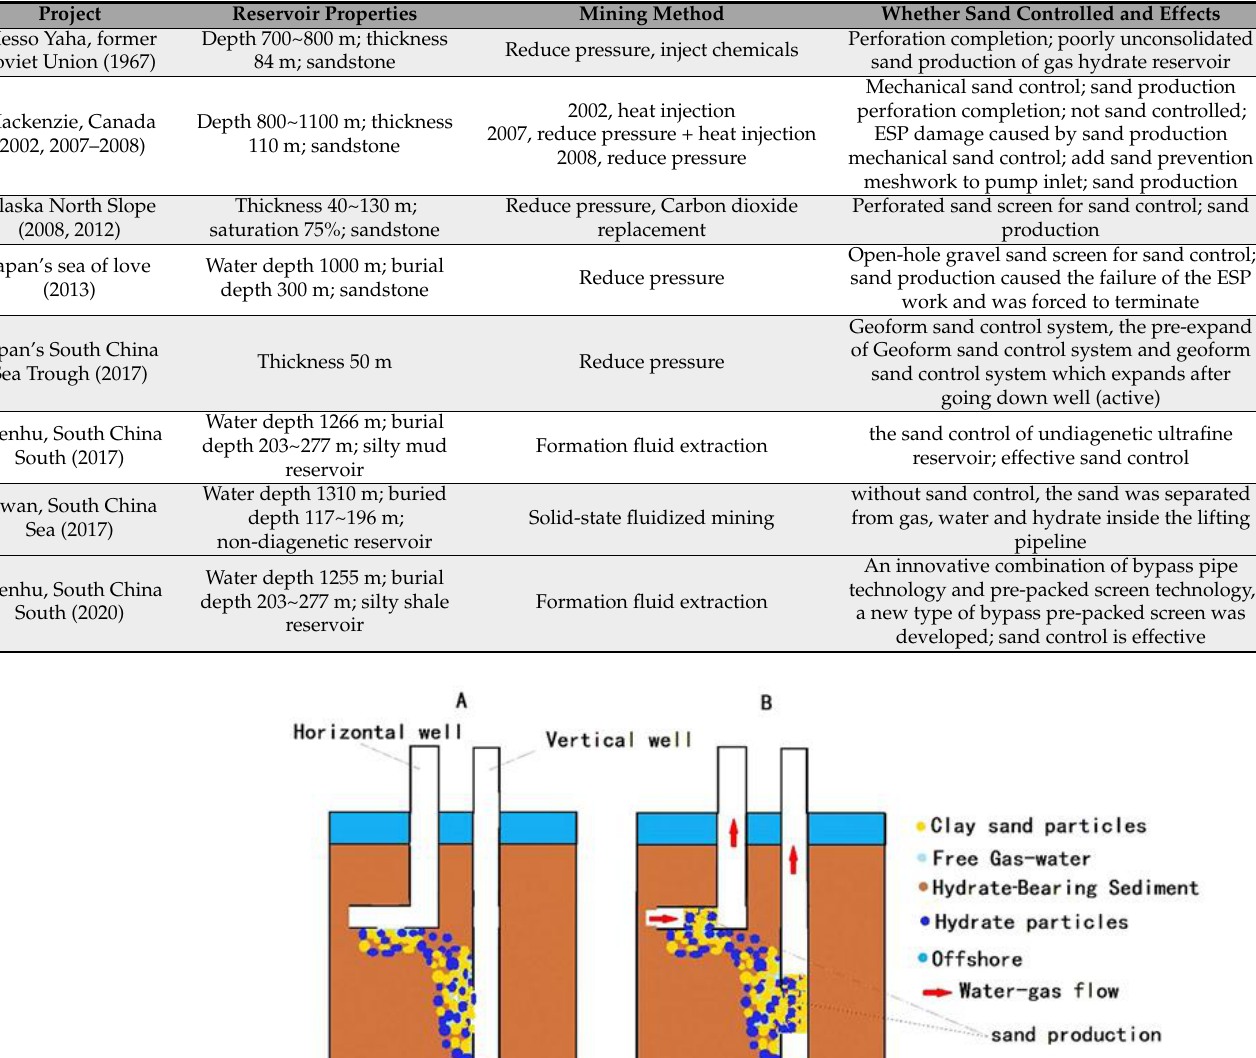
Table 1. Hydrate mining method and sand control technology.